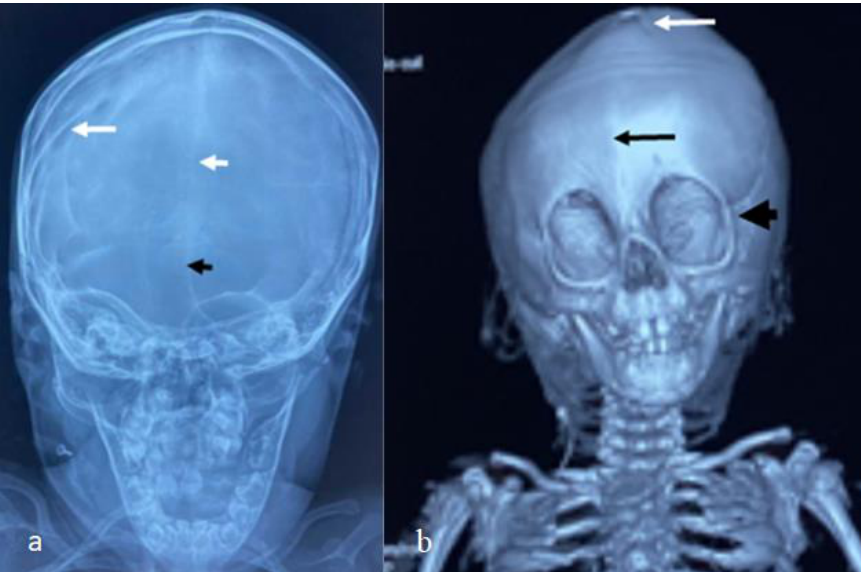
Figure 2. AP skull radiograph at the age of 12 months-old-boy- showed early closure of the metopic (black arrow head) and sagittal sutures (white arrow head) and partial closure of the right coronal suture (white arrow), leading to development of skull–crown asymmetry. Three-dimensional reconstruction CT scan of the same child at the age of 14 months showed a well-defined palpable bony ridge (black arrow) extending from the metopic suture upwards to include the sagittal suture (white arrow) ( a ); Note that the extremely large orbital cavities (arrowhead) with diffuse early closure of the metopic and the sagittal sutures arrow), leading to the development of a dysmorphic and asymmetrical contour of the head because of the unilateral upward bulging of the crown (white arrow). Asymmetrical contour of the cranium resulted from the unilateral partial closure of the right coronal suture with the simultaneously but asymmetrical early closure of the squamosal sutures ( b ).